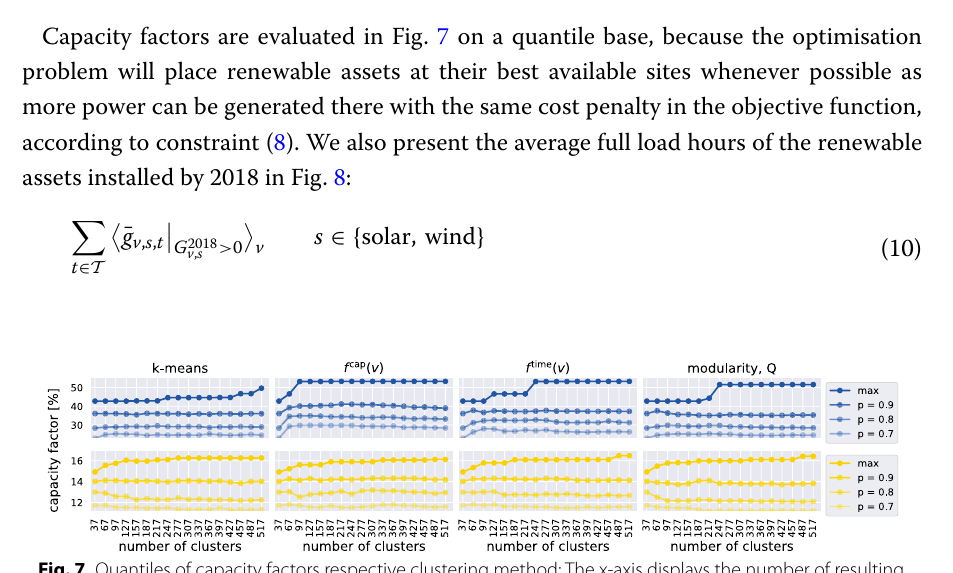
Fig. 7 Quantiles of capacity factors respective clustering method: The x-axis displays the number of resulting regions, the y-axis the resulting 90% , 80% and 70% quantiles of the capacity factors for wind ( 1 st row) and solar